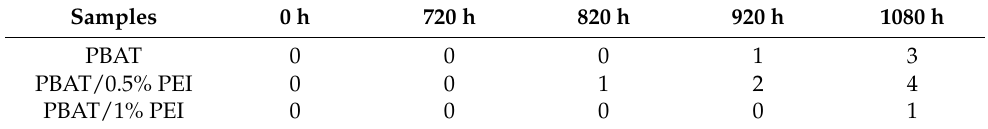
Table 7. Classification of degradation grades of films in the accelerated photoaging test. Samples